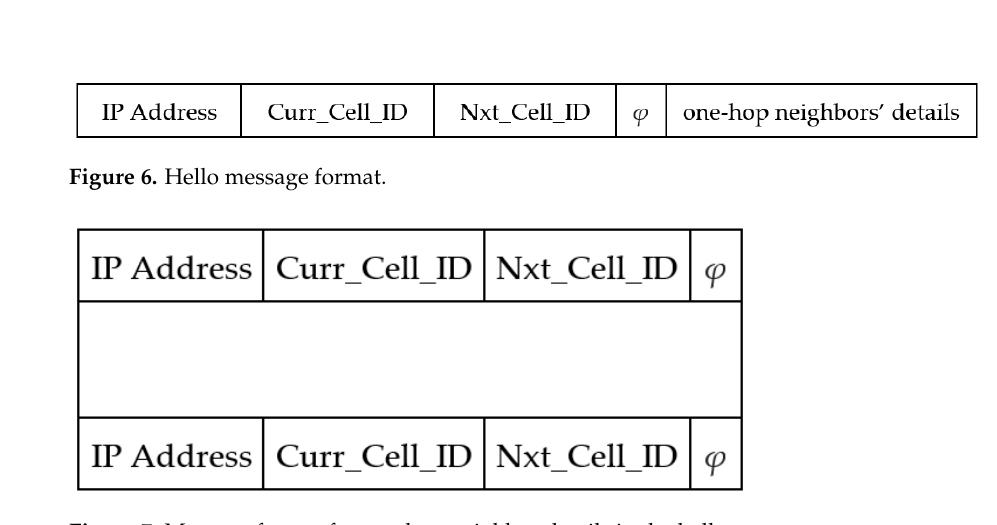
Figure 8. Global pheromone map and location information message format.